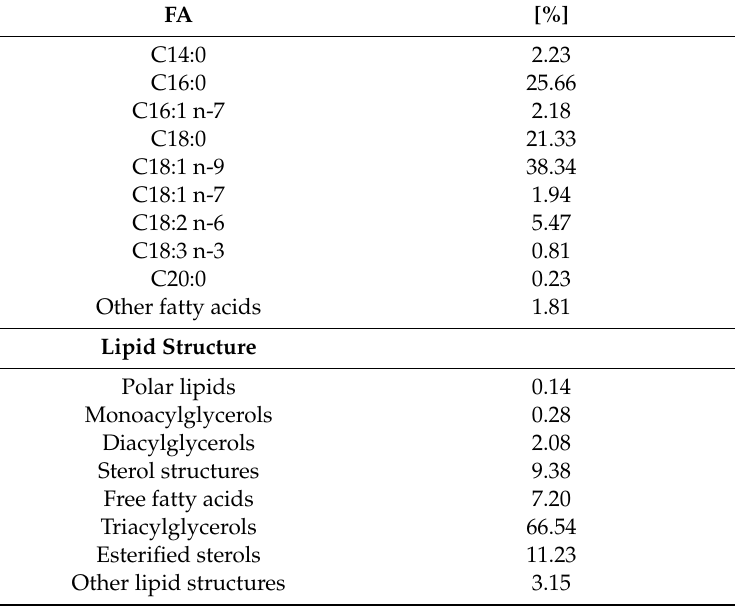
Table 1. Fatty acid (FA) composition and percentage of individual lipid components of animal fat (AF) by-products used for the solid-state fermentation by Mortierella